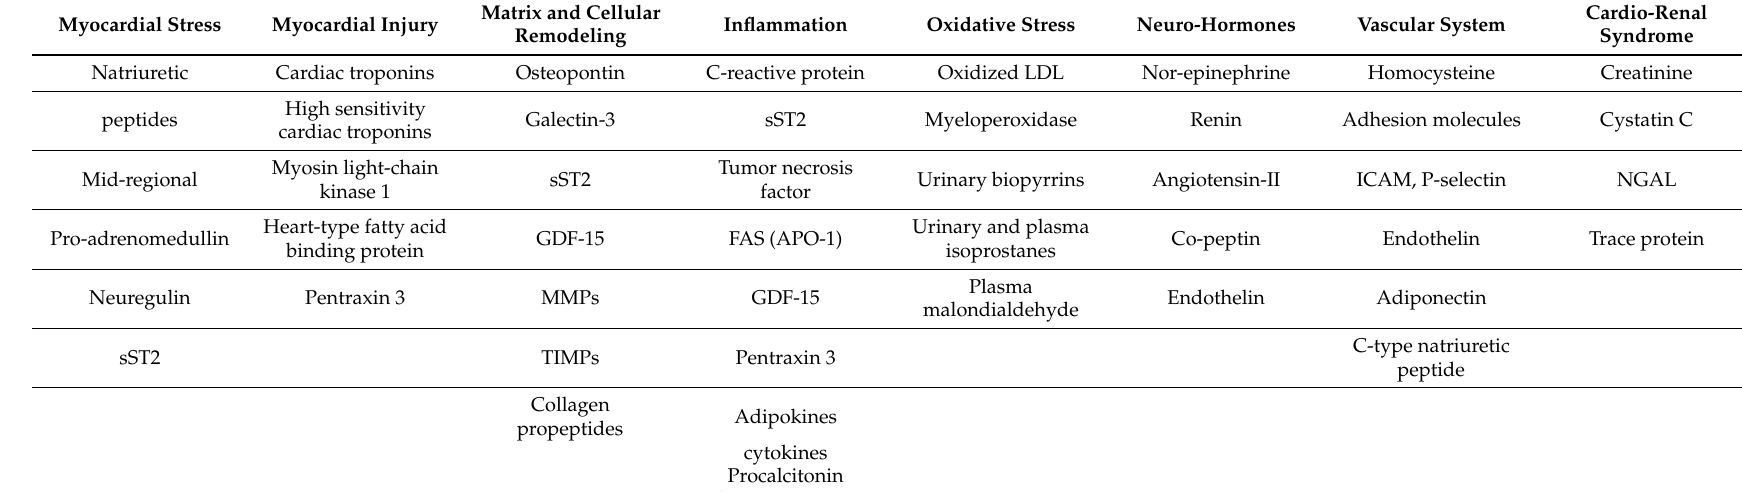
Table 1. The specific biomarkers expressed in heart failure (HF) patients as they correlate to the underlying mechanism of the pathogenesis for HF could be utilized for the diagnosis and prognosis of HF. Adapted from Ahmad et al., 2012 [30]. APO, apoptosis antigen; GDF, growth differentiation factor; ICAM, intercellular